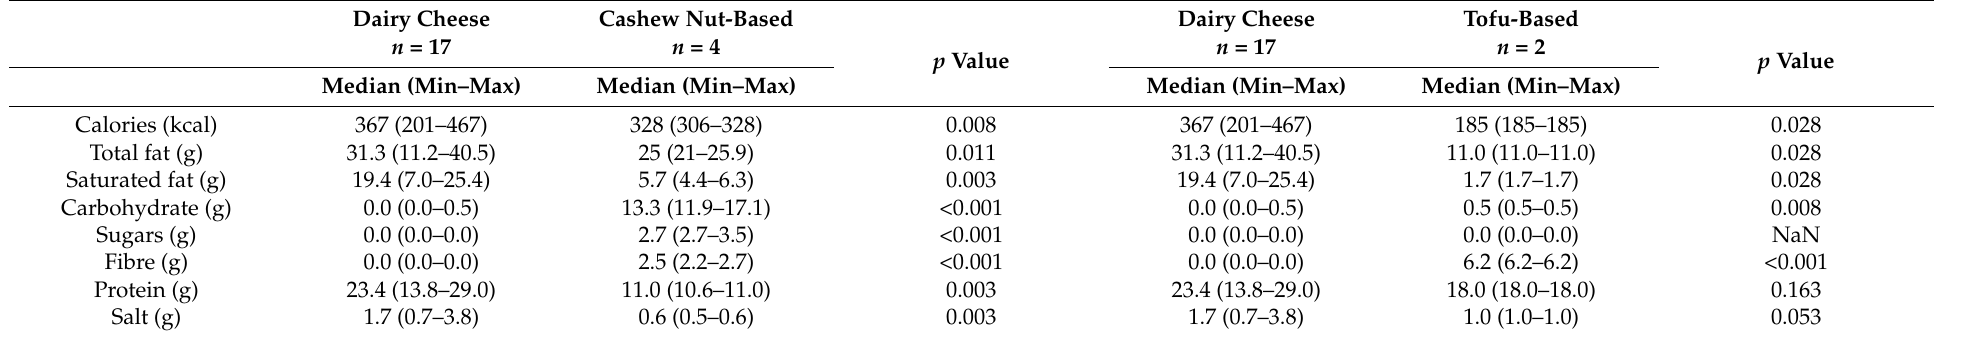
Table 4. Median (minimum-maximum) values of calories and nutritional content of those dairy cheese and cashew nut- and tofu-based cheese alternatives formatted as block and slices per 100